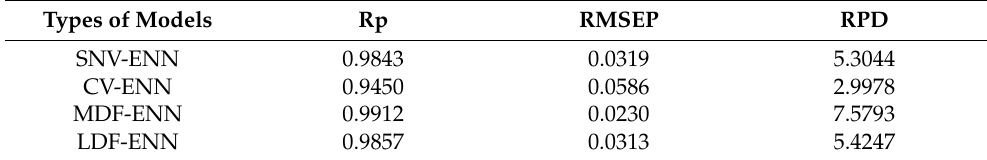
Table 2. Model performance indicators based on data fusion and single